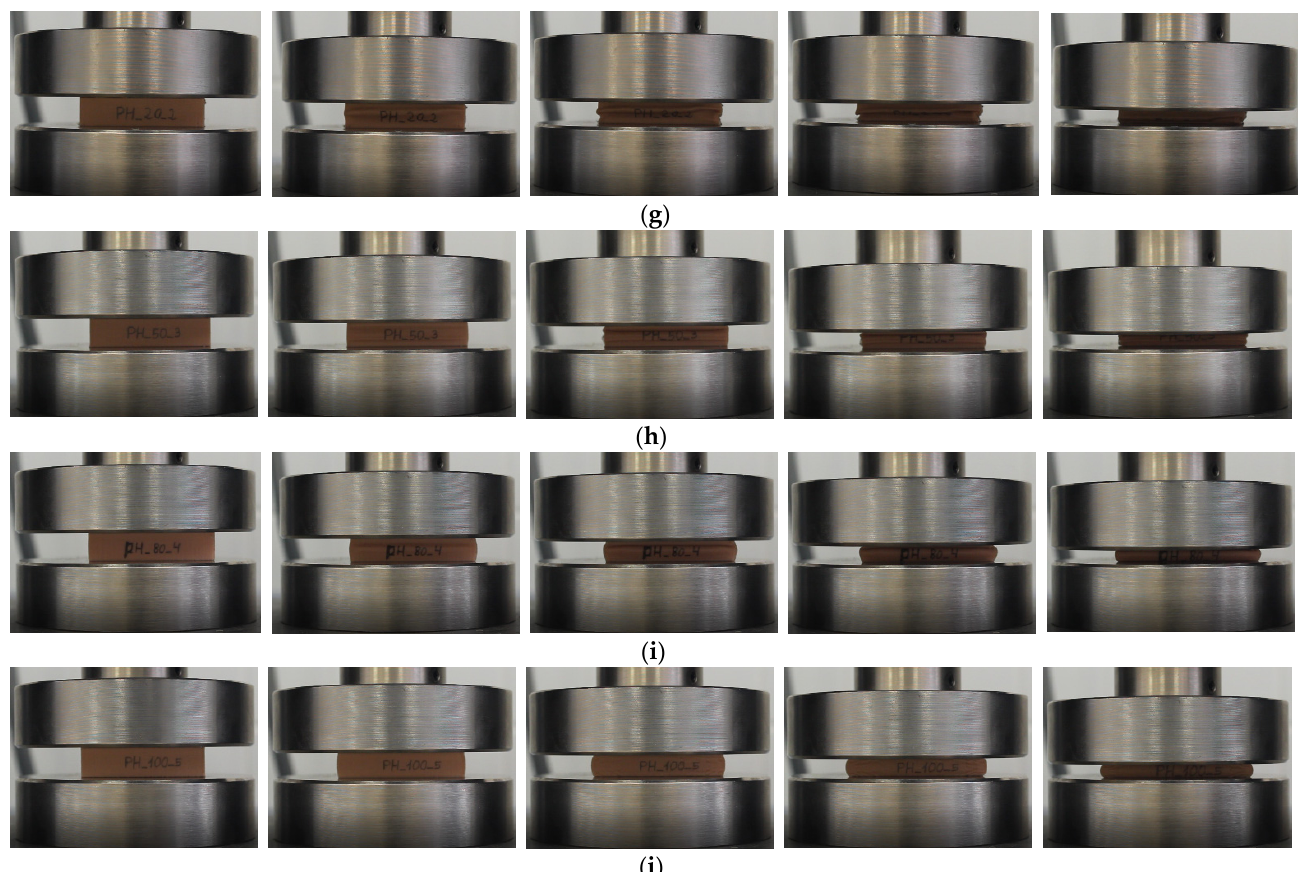
Figure A1. Test video with horizontal specimens: ( a ) CH 0%; ( b ) CH 20%; ( c ) CH 50%; ( d ) CH 80%; ( e ) CH 100%; ( f ) PH 0%; ( g ) PH 20%; ( h ) PH 50%; ( i ) PH 80%; ( j ) PH 100%.